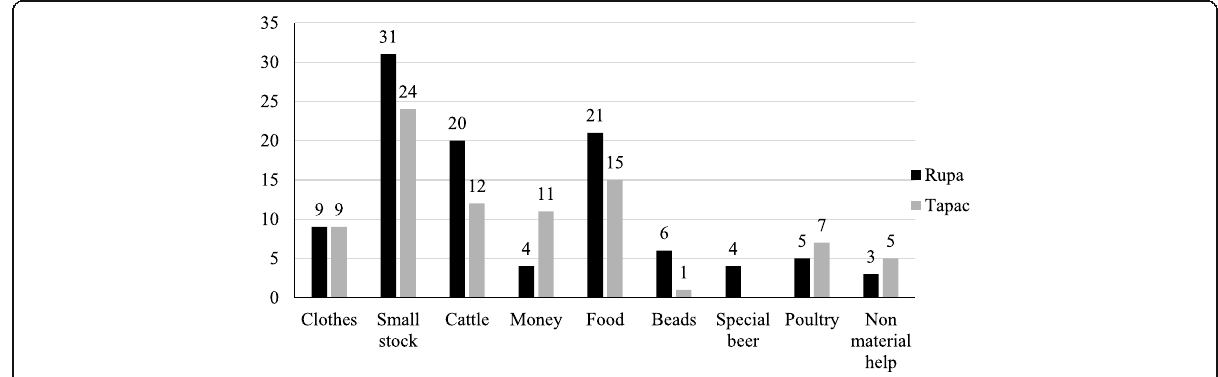
Fig. 1 Frequency distribution of gifts exchanged by women and their friends by location